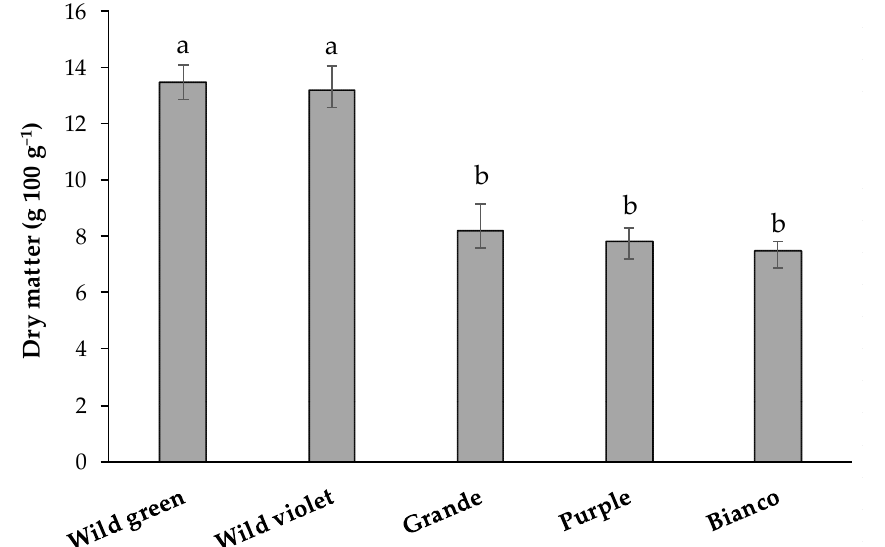
Figure 2. Average dry matter (DM) in different genotypes of raw asparagus ( p ≤ 0.001). The same letters indicate that mean values are not significantly different ( p = 0.05). Vertical bars indicate standard deviation. Grande = ‘Grande’; Purple = ‘Purple Passion’; Bianco = ‘Bianco di Bassano del Grappa’.